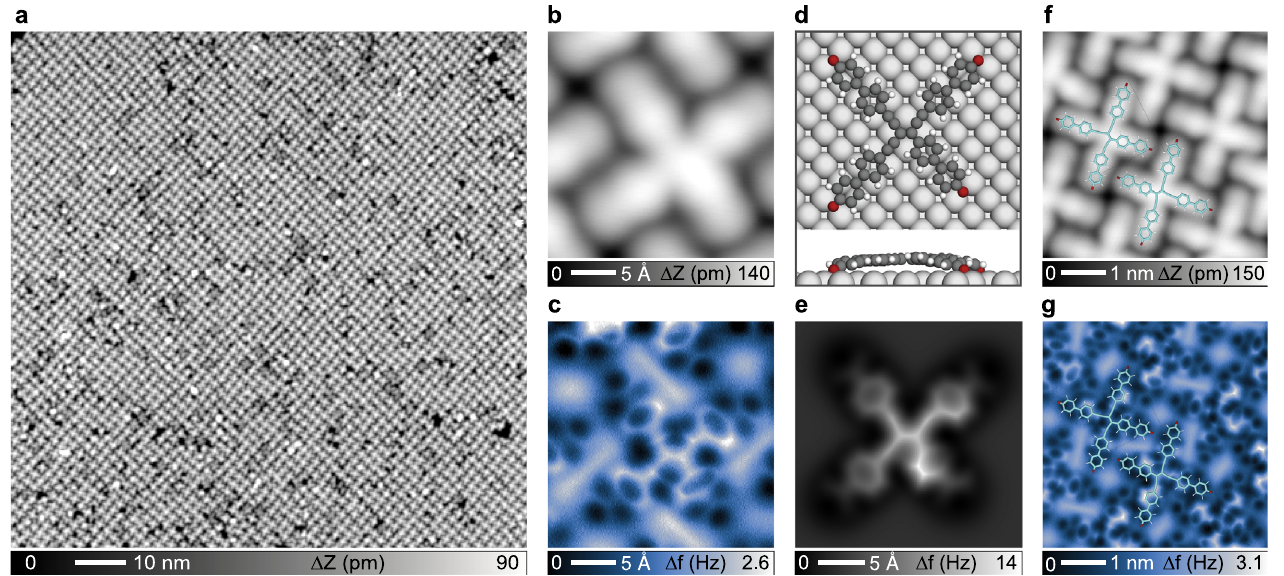
Fig. 4 | Selective on-surface synthesis of enetriynes upon annealing the orga- nometallic arrays at 520K. a Representative large-scale STM image of tetramer superlattice. b High-resolutionSTM image ofa tetramer unit. c The corresponding bond-resolved AFM characterization reveals the carbon backbone. d DFT calcu- lated structural model of an enetriyne species adsorbed on Ag(100). e Simulated